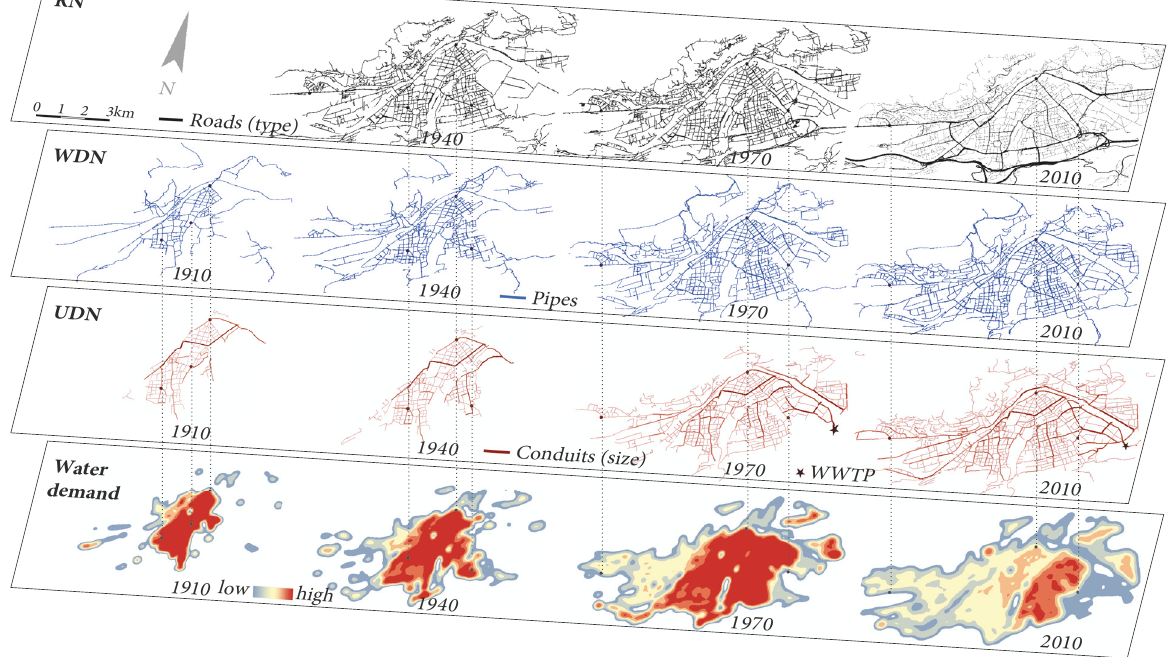
Figure 2: Time-stamped coevolution of the water distribution network (WDN), the urban drainage network (UDN), and the road network (RN) of an Alpine